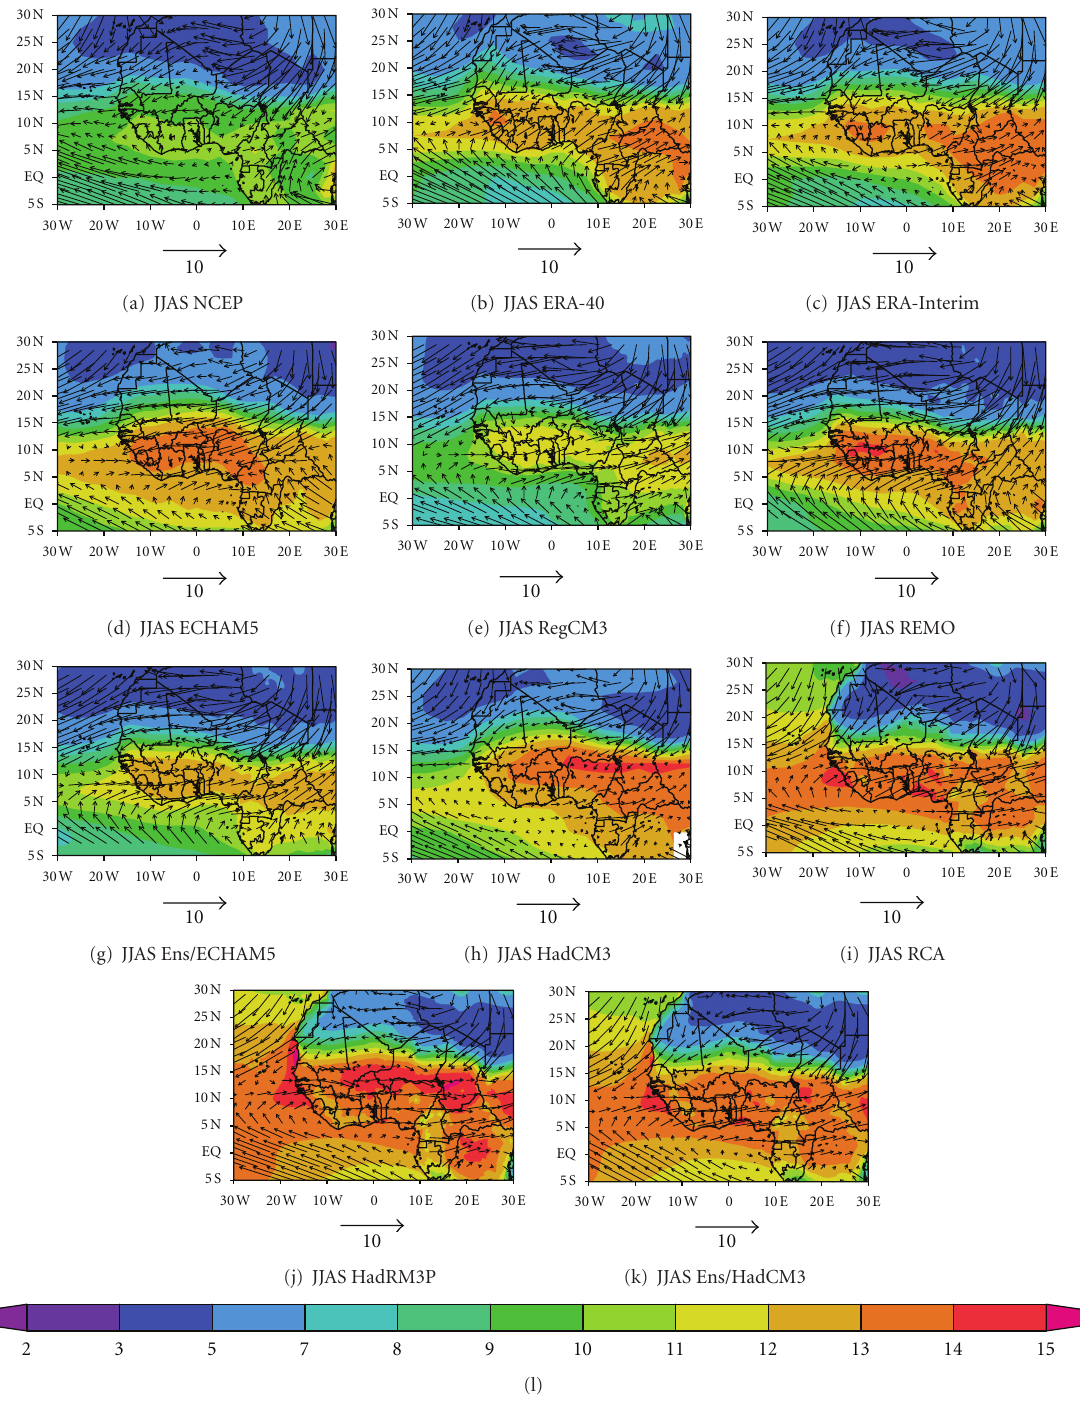
Figure 6: 1981–2000 averaged JJAS of 850hPa wind vectors (in meters per second) superimposed to specific humidity (shaded in grams per kilogram) from: (a) NCEP reanalysis, (b) ERA-40 reanalysis, (c) ERA-Interim reanalysis, (d) ECHAM5, (e) RegCM3, (f) REMO, (g) Ens/ECHAM5 (ensemble mean of RCMs driven by ECHAM5), (h) HadCM3, (i) RCA, (j) HadRM3P, and (k) Ens/HadCM3 (ensemble mean of RCMs driven by